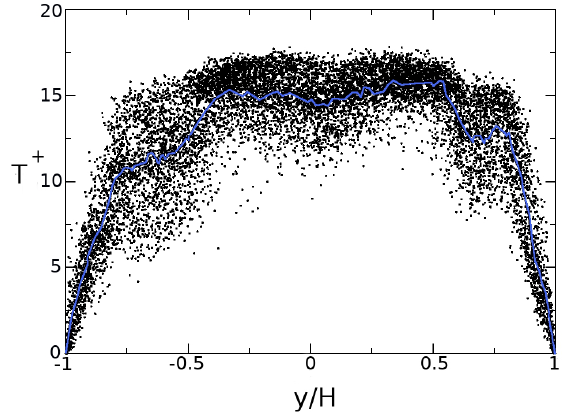
Figure 5. Filtered density function (FDF) simulations of the cooled channel flow. Scatter plot of the temperature of stochastic particles with the corresponding filtered temperature profile (solid line); see [95]. Reproduced with permission from Wacławczyk, M.; Pozorski, J. and Minier, J.-P., Flow, Turbulence and Combustion; published by Springer,